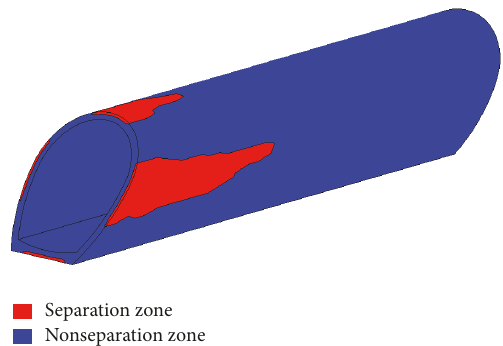
Figure 12: Separation zone distribution of lining after the earth- quake.